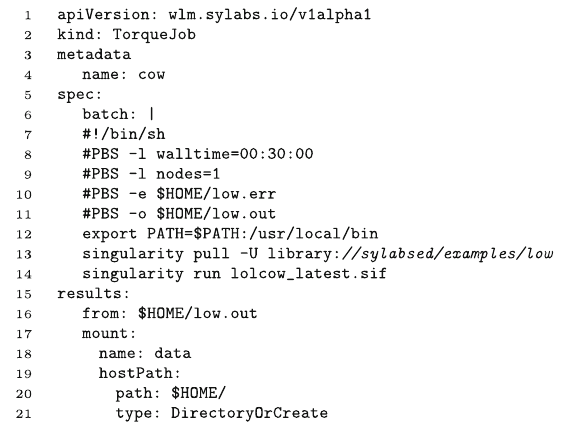
Fig. 7 An example of the Kubernetes yaml script. The script encloses a PBS script. Submission is performed as a normal yaml job submission, i.e. $kubectl apply -f